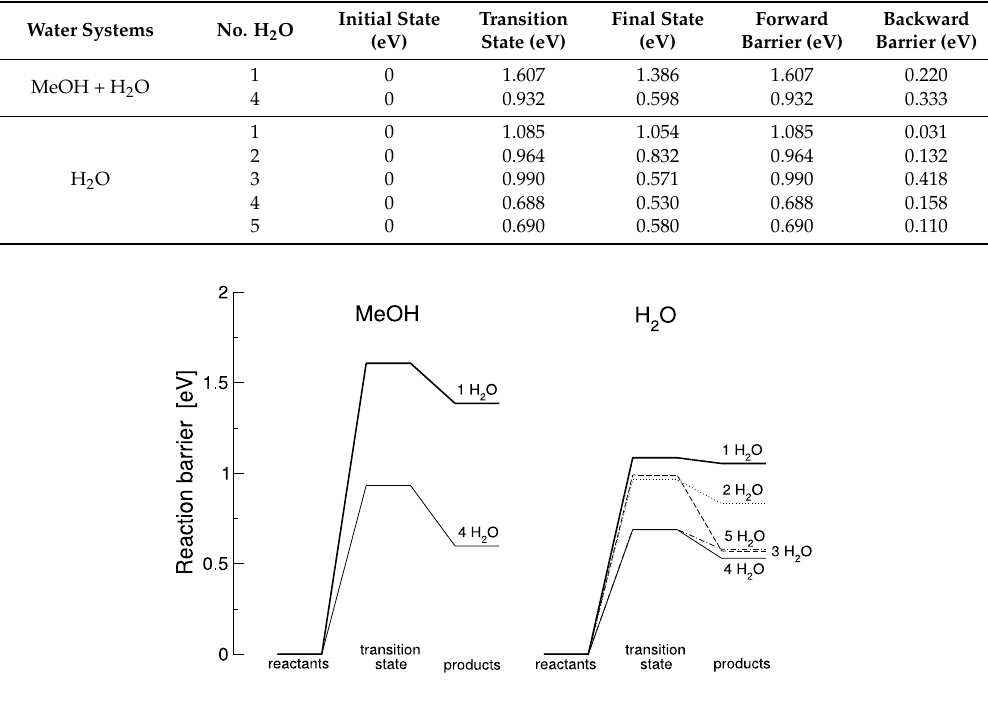
Figure 4. Reaction barriers for the MeOH assisted and pure H 2 O dissociation in the presence of varying amounts of additional water molecules.